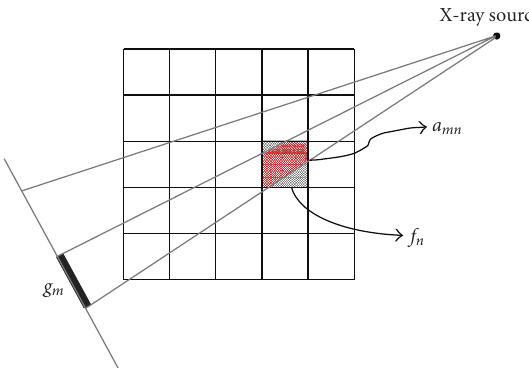
Figure 1: Projection model of a discrete image in fan-beam